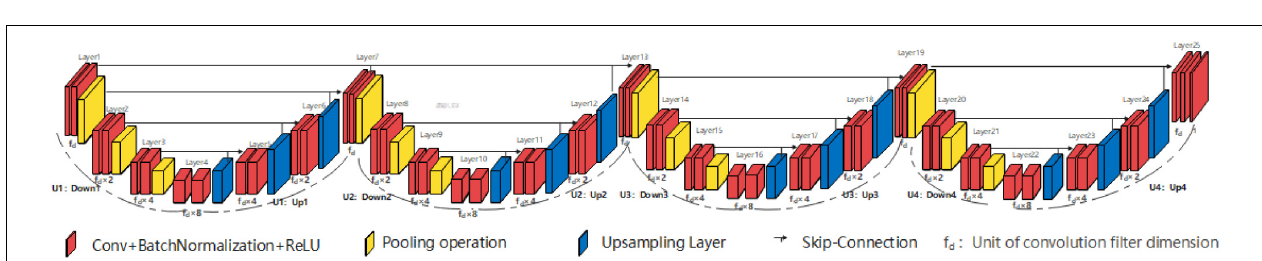
FIGURE 5 | Structure diagram of three high peak horizontal EUNet (THP-horizontal EUNet) U 1 (4-4)-U 2 (4-4)-U 3 (4-4)-U 4